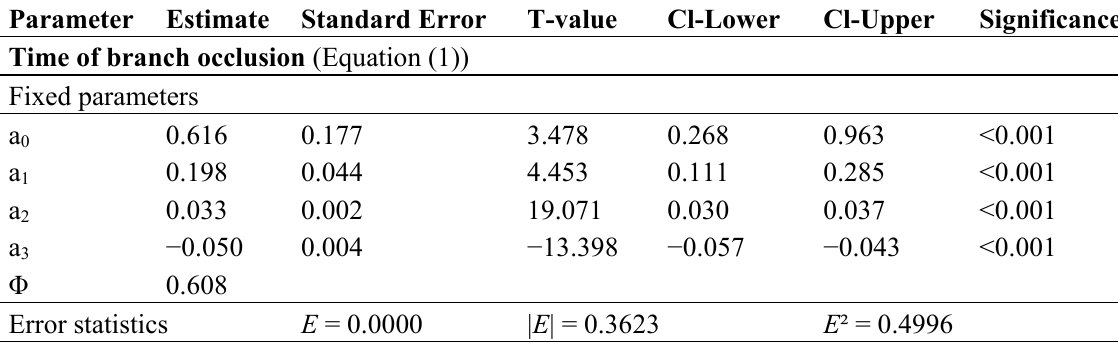
Table 6. Parameter estimates of the model for the time of branch occlusion, radius of dead knot, radius of knot and insertion